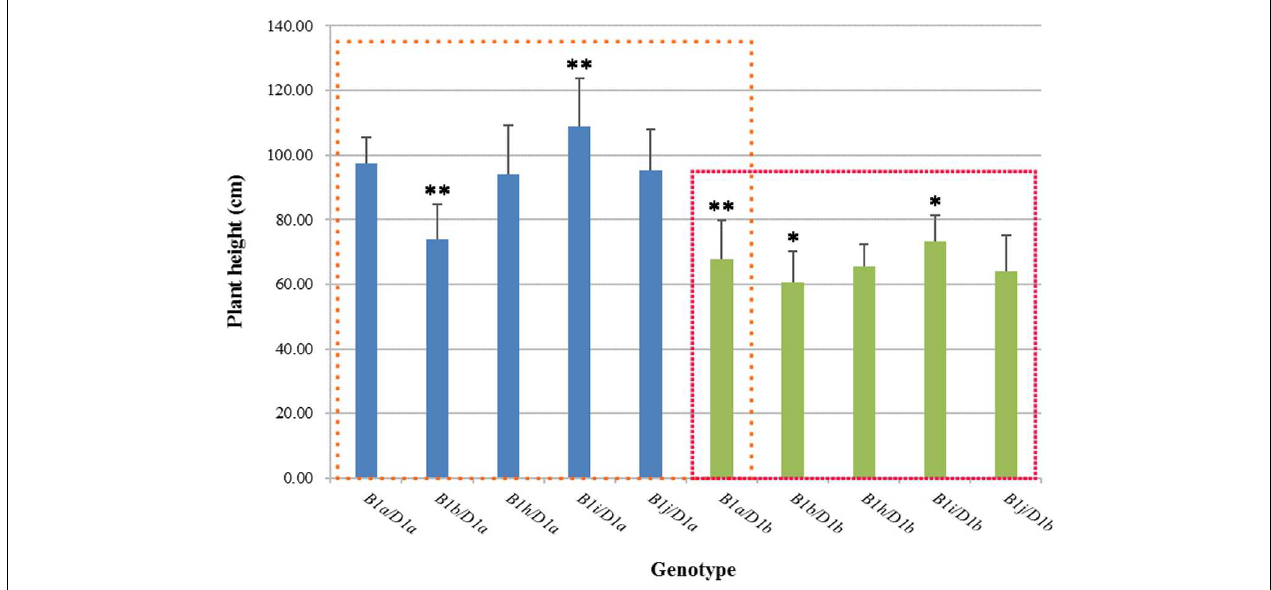
FIGURE 1 | Plant height in different Rht-B1 genotypes of wheat. The blue column represents Rht-B1 allelic variations against the Rht-D1a background, and the green column represents Rht-B1 allelic variations against the Rht-D1b background; the left box compares plant height for different genotypes using B1a / D1a as a control, and the right box compares plant height for different genotypes using B1a / D1b as a control. ∗ , ∗∗ Denotes significant differences at 5 and 1% probability levels, respectively.